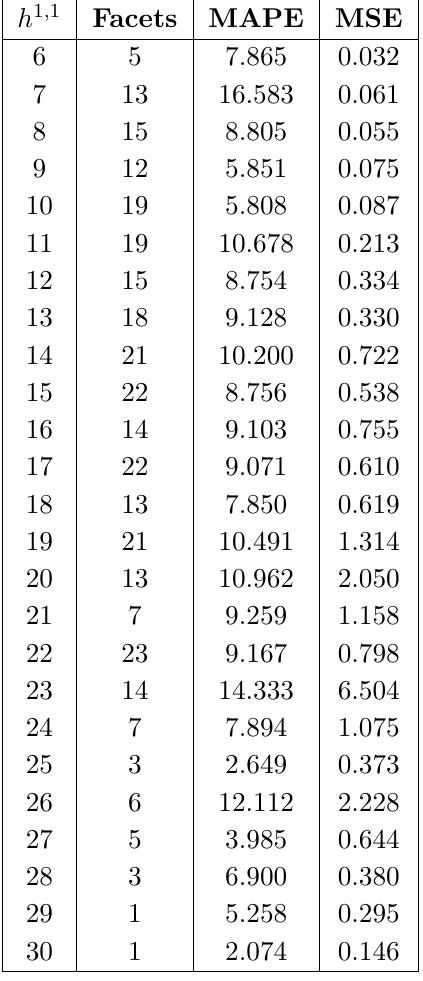
Table 6 . Performance of our model across h 1 ; 1 of the 3d re(cid:13)exive